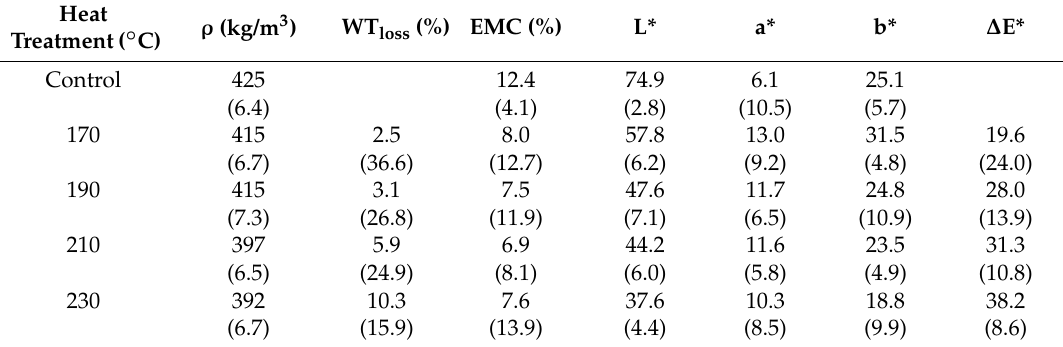
Table 1. Average wood density ( ρ ), weight loss (WT loss ), equilibrium moisture content (EMC) and color parameters (L*—lightness, a*, b*—chromaticity on green-red and blue-yellow axis; ∆ E—total color difference) of wood after heat treatment (2nd row present Coef. of variation